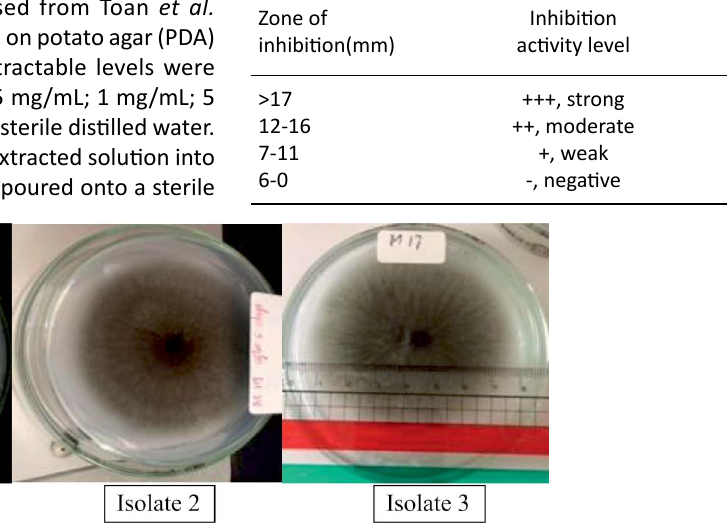
Fig. 1. Production of fungal enzyme of three isolates with GYP agar medium.